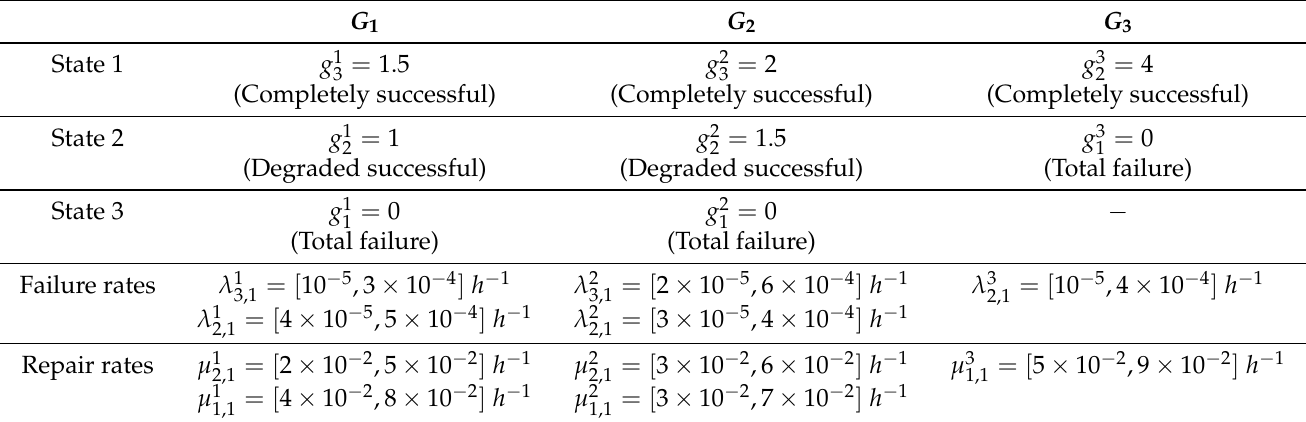
Table 6. Transition rates and states for each component.